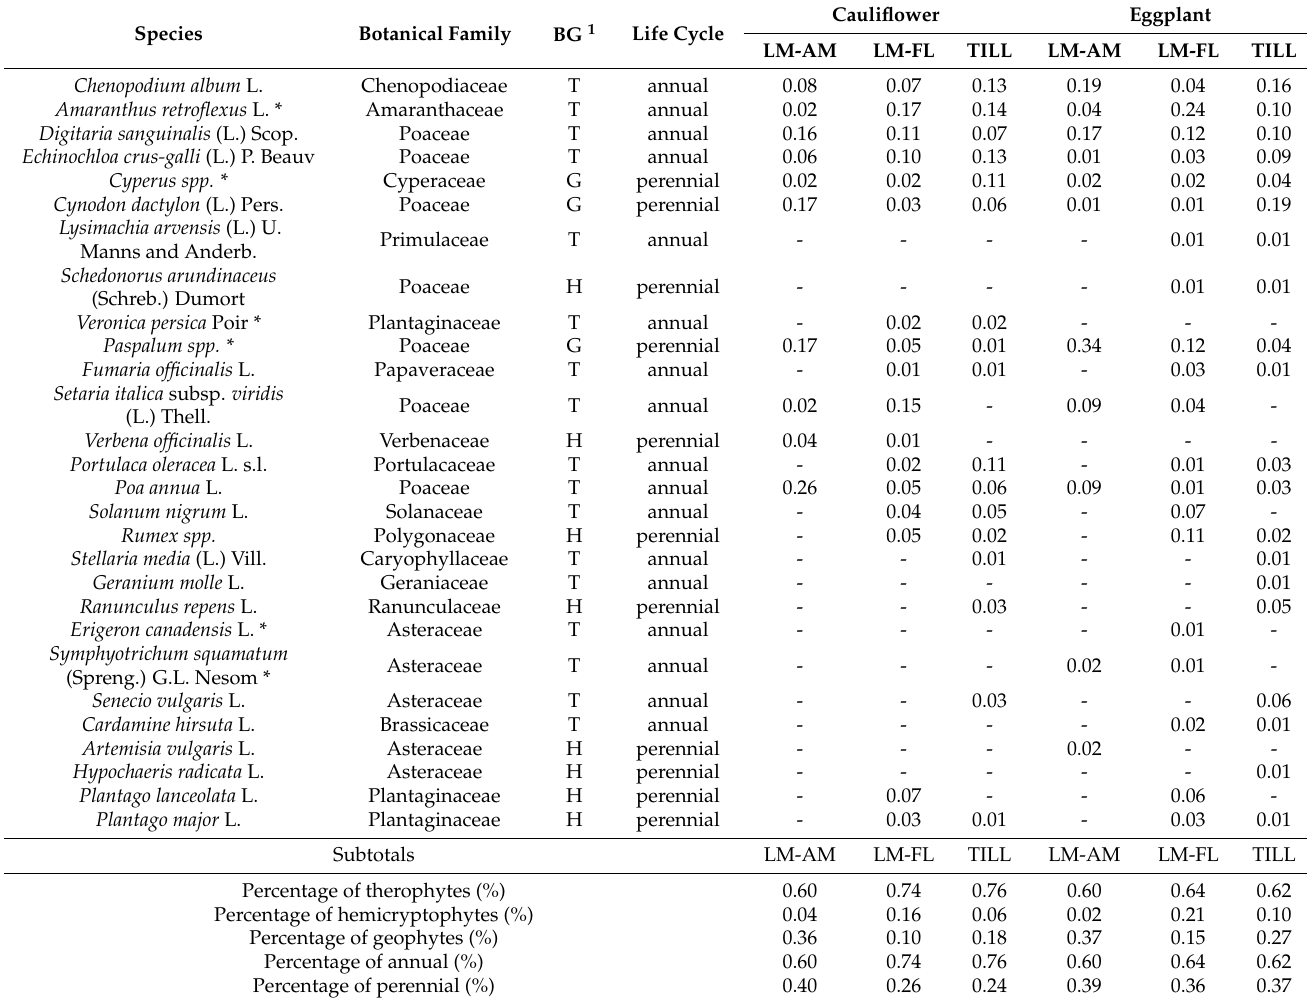
Table 2. Binomial name, botanical family, biological group (BG), life cycle, and average midpoint percentage cover values of the major weed species under three different management systems (LM-AM, LM-FL, TILL) and for the two cash crops (cauliflower and eggplant). Data were pooled over years and repetitions. LM-AM: Living mulch autonomously mowed; LM-FL: living mulch managed with flaming; TILL: conventional